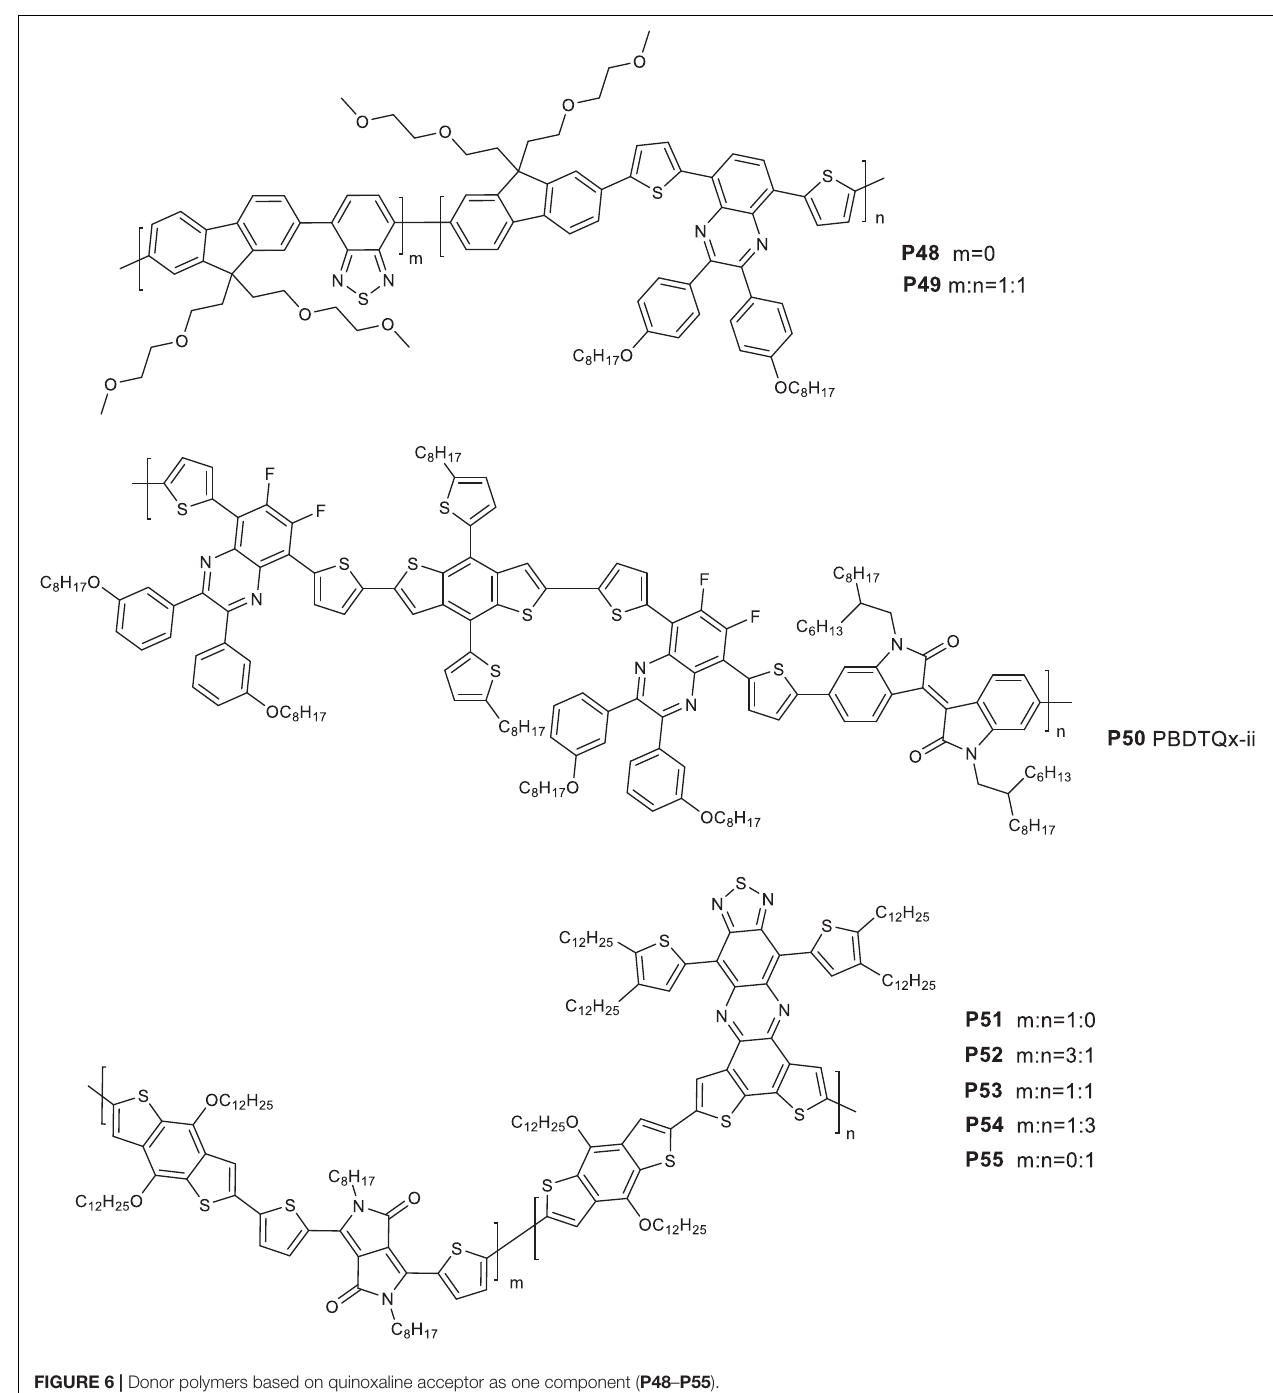
V OC slightly increases. The morphology of the films (GIWAXS and TEM) was similar. PL quenching efficiencies of films